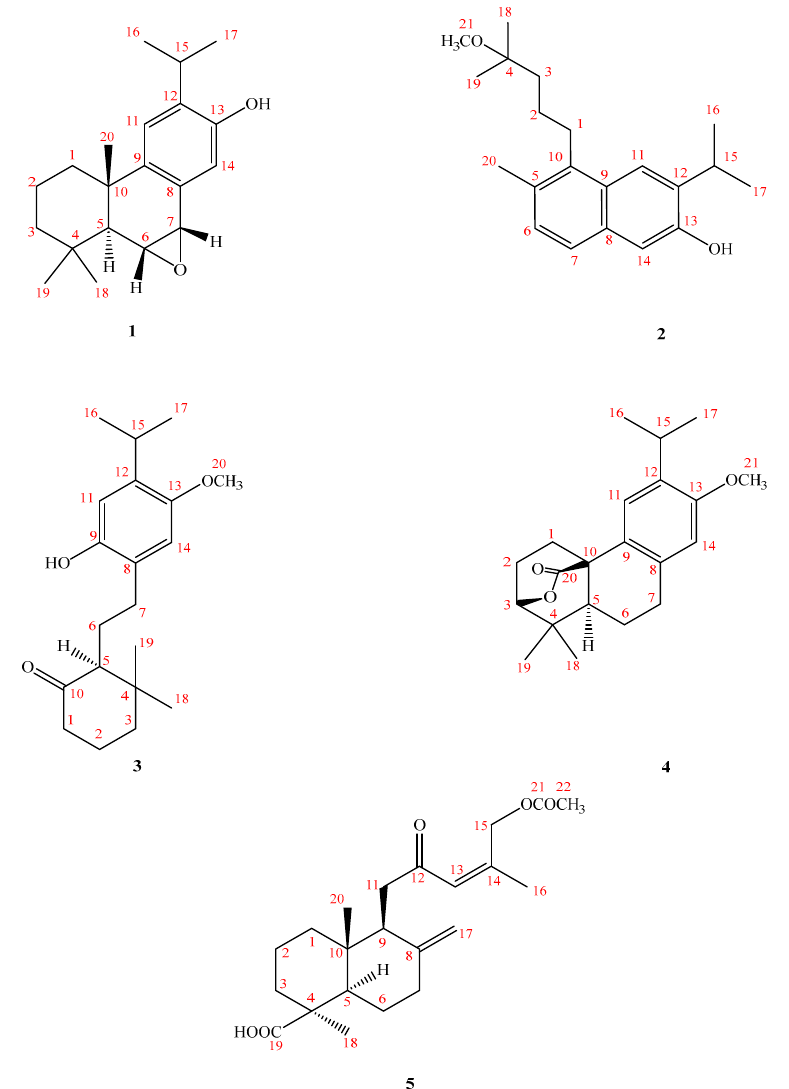
to seven indices of hydrogen deficiency (IHD). Analysis of its IR spectrum suggested that Compound 1 contained OH (3340 cm − 1 ) and aromatic (1610 cm − 1 ) and epoxide (1510 and 1233 cm − 1 ) moieties. The 1 H-NMR spectrum (see Supplementary Materials) revealed signals for an iPr group at δ H 1.23 (6H, d, J = 7.4 Hz, and CH 3 -16/17) and 3.06 (1H, sep, J = 7.4 Hz, and H-15); three Me singlets at δ 1.29, 1.26, and 1.22 (each s, 3H); two oxymethines at δ H 3.40 (dd, J = 10.8, 4.2 Hz, and H-6) and 5.18 (1H, br d, J = 4.2 Hz, and H-7); and a resonance at δ H 2.28 (1H, br d, and J = 13.2 Hz) that was characteristic for the H β -1 signal of a dehydroabietane [12]. By comparing the 1 H-NMR of Compound 1 with that of the known compound ferruginol [12], it was deduced that Compound 1 was indeed an abietane diterpene (Figure 2).